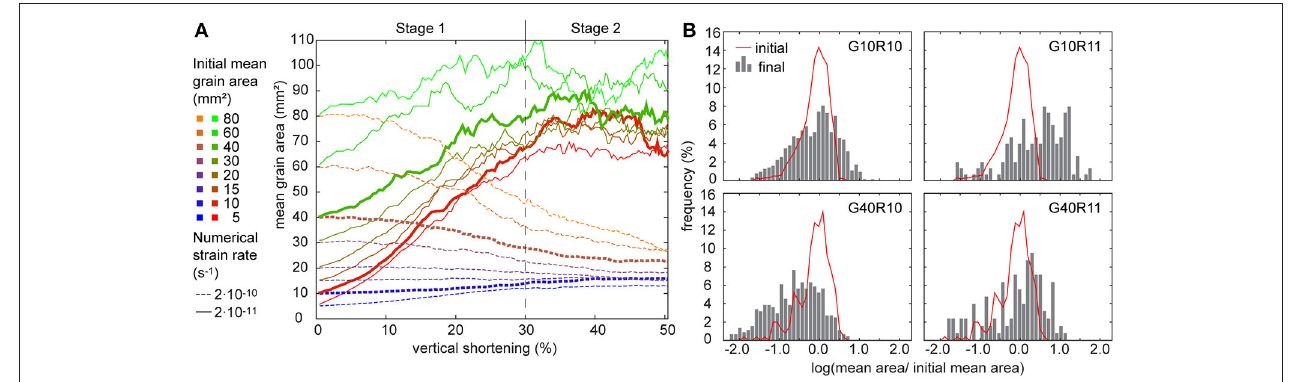
FIGURE 5 | Overview of grain-area evolution in the numerical simulations. (A) Mean grain-area as a function of vertical shortening. In a first stage until approximately 30% shortening, mean grain areas either increase or decrease, which is followed by a second stage of more stable grain areas. Simulation results shown in detail in (B) (10 mm 2 and 40 mm 2 ) are highlighted as bold lines. (B) Grain area histograms of selected simulations at initial and final simulation step. Areas were normalized to initial mean